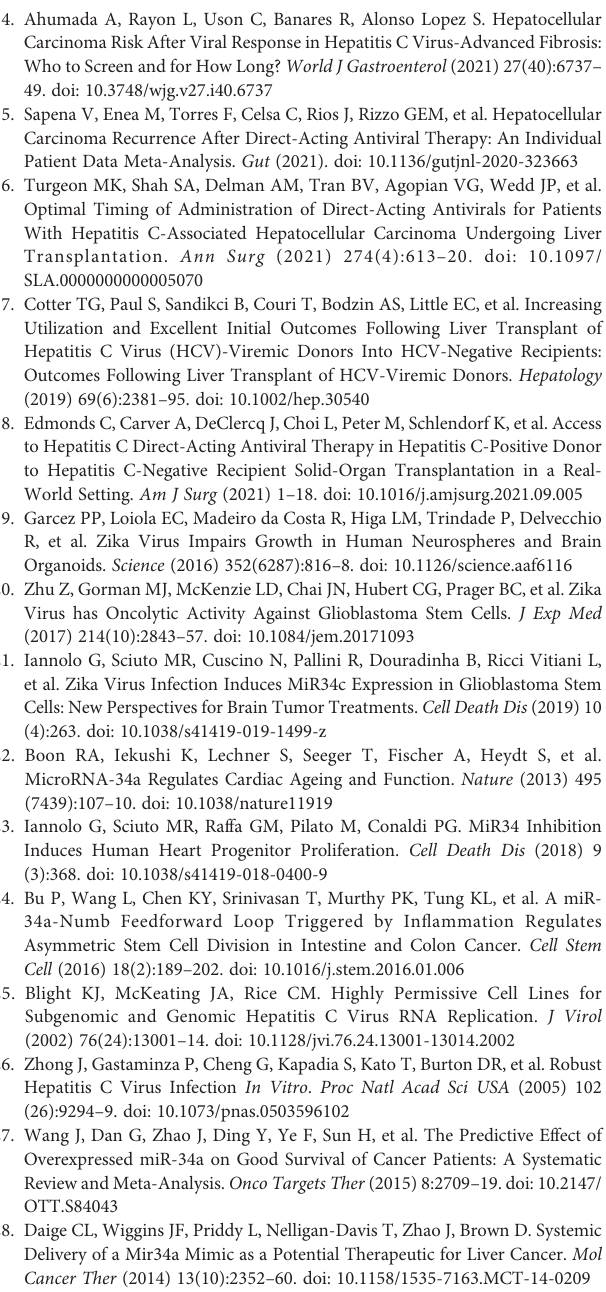
differentsamples (pvalue * ≤ 0.05, ** ≤ 0.005). (C) protein quanti fi cation, the analysis was carried out in triplicate (p value ≤ 0.05). Supplementary Figure 2 | Viral expression from the supernatant of Huh7.5 HCV infected and Huh7.5 CI HCV. HCV was quanti fi ed as described in material and methods by immunoassay. The analysis has been performed on three different samples (p value **** ≤ 0.0001). Supplementary Figure 3 | Digital PCR analysis showing the expression of miR34a after miR34 overexpression vs. control The reported data are representative of experiments performed in triplicate (*p value ≤